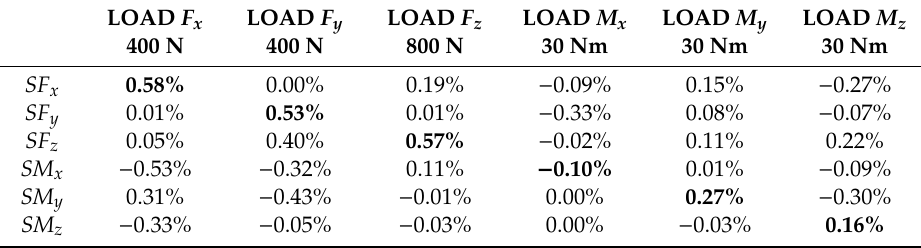
Table 7. Cross-talk and error readings of the FEA results of the sensor with